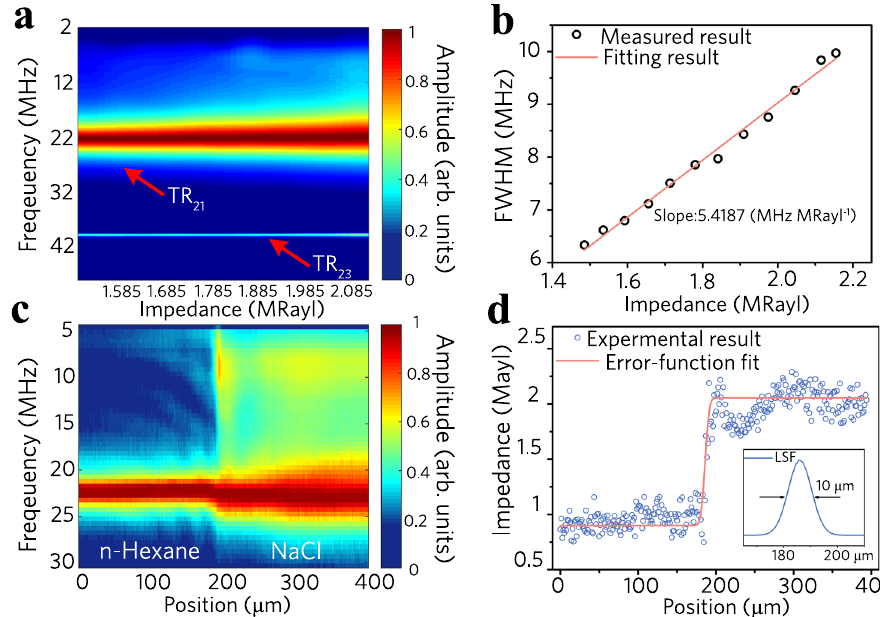
Fig. 3 Optoacoustic sensing in liquids. a Measured acoustic spectra with varying surrounding impedance Z . b Full width at half maximum of the TR 21 mode versus acoustic impedance Z . c , d Spatial resolution characterization. c Surface plot of the acoustic spectrum at each scanning position z . d Measured impedance Z variation across the liquid interface. FWHM, Full width at half maximum. LSF, Line spread